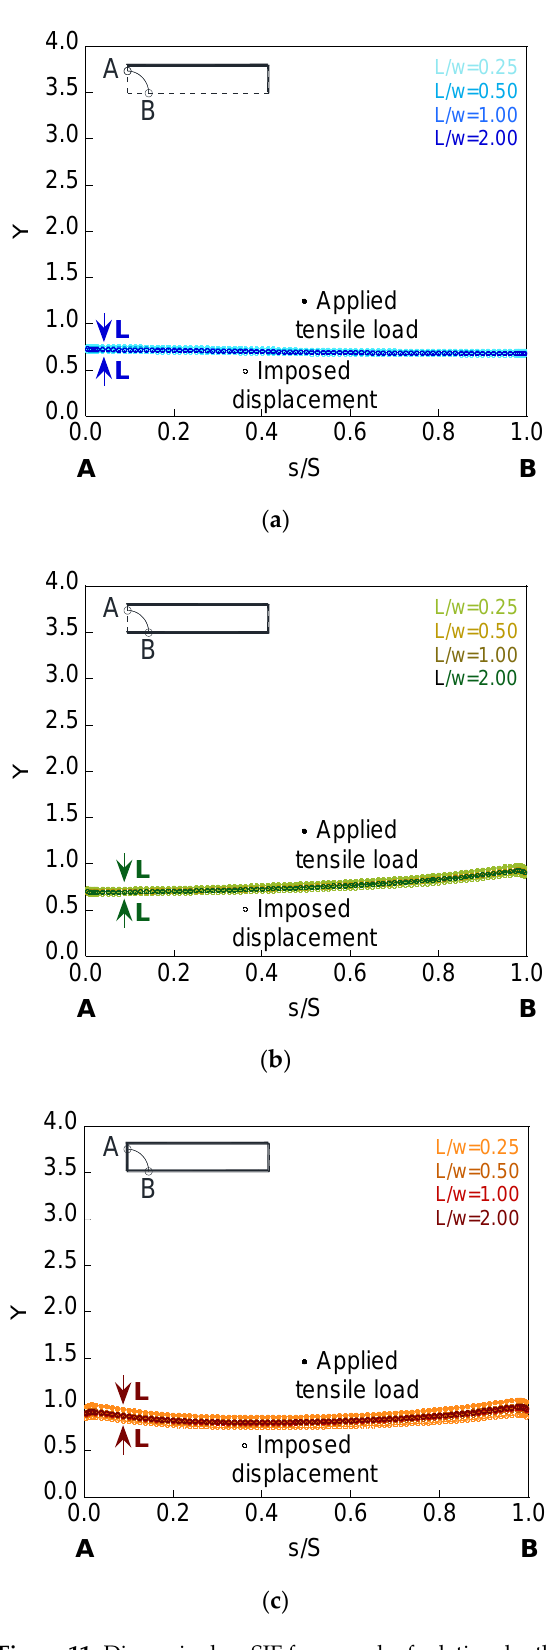
Figure 11. Dimensionless SIF for a crack of relative depth a / t = 0.8 and aspect ratio a / b = 1.0 in finite- thickness plates of relative lengths L / w = {0.25, 0.50, 1.00, 2.00} for the ( a ) embedded configuration, ( b ) superficial configuration, and ( c ) corner configuration.